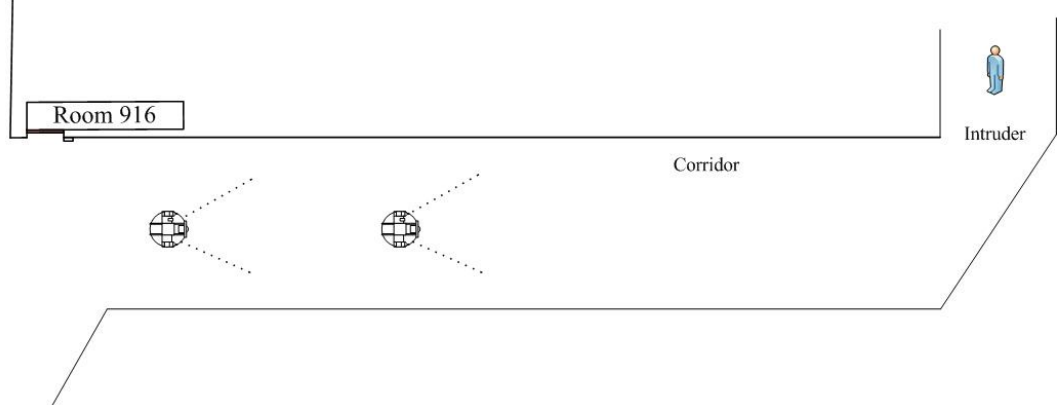
Figure 27. Twin robots on an indoor patrol.